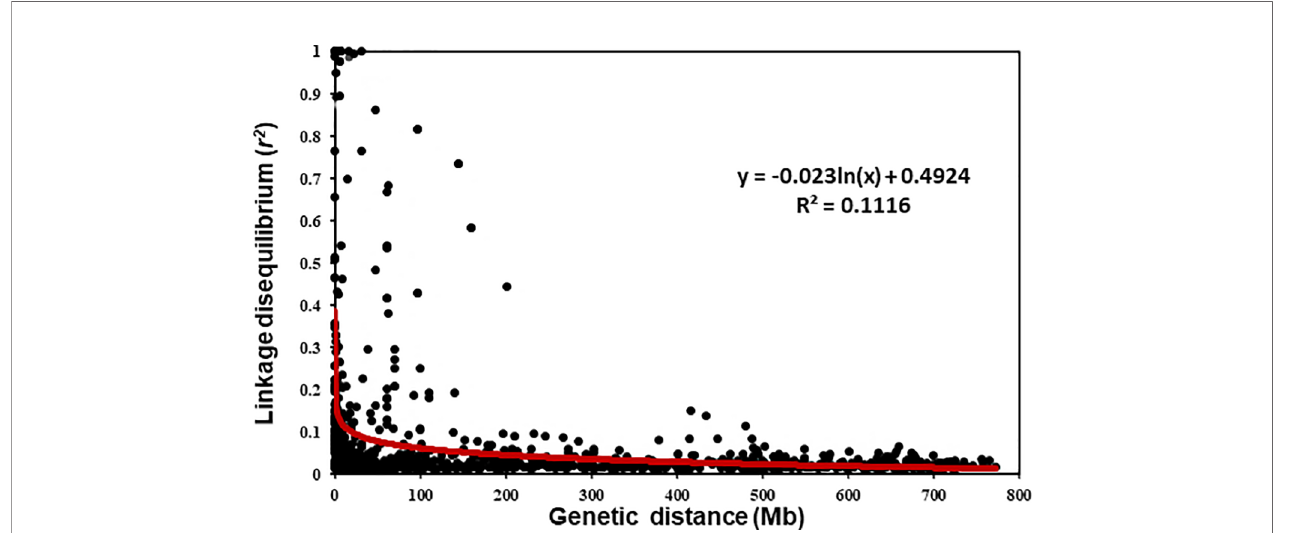
FIGURE 3 | Overview of the linkage disequilibrium (LD) parameter R 2 of the intra-chromosomal pairs in the winter wheat panel.